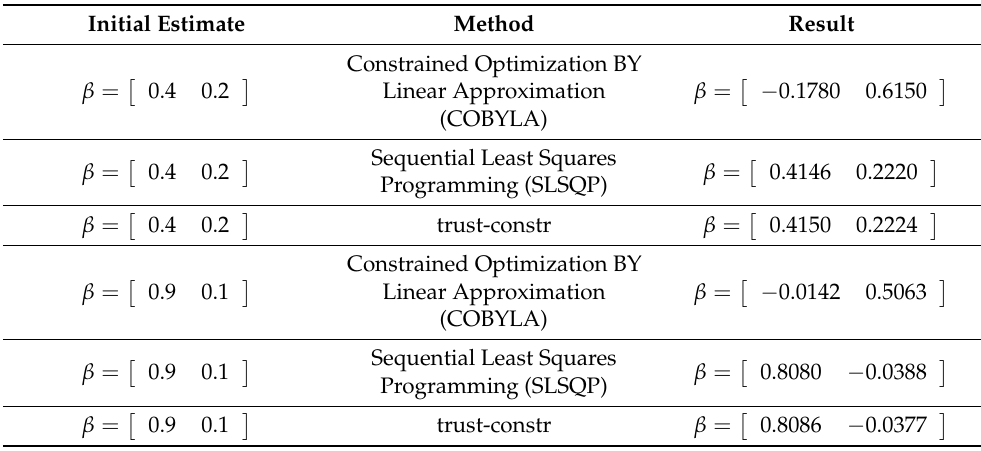
Table 2. Results for water/n-octane system using different methods for the minimize function of Scipy-Optimize package for